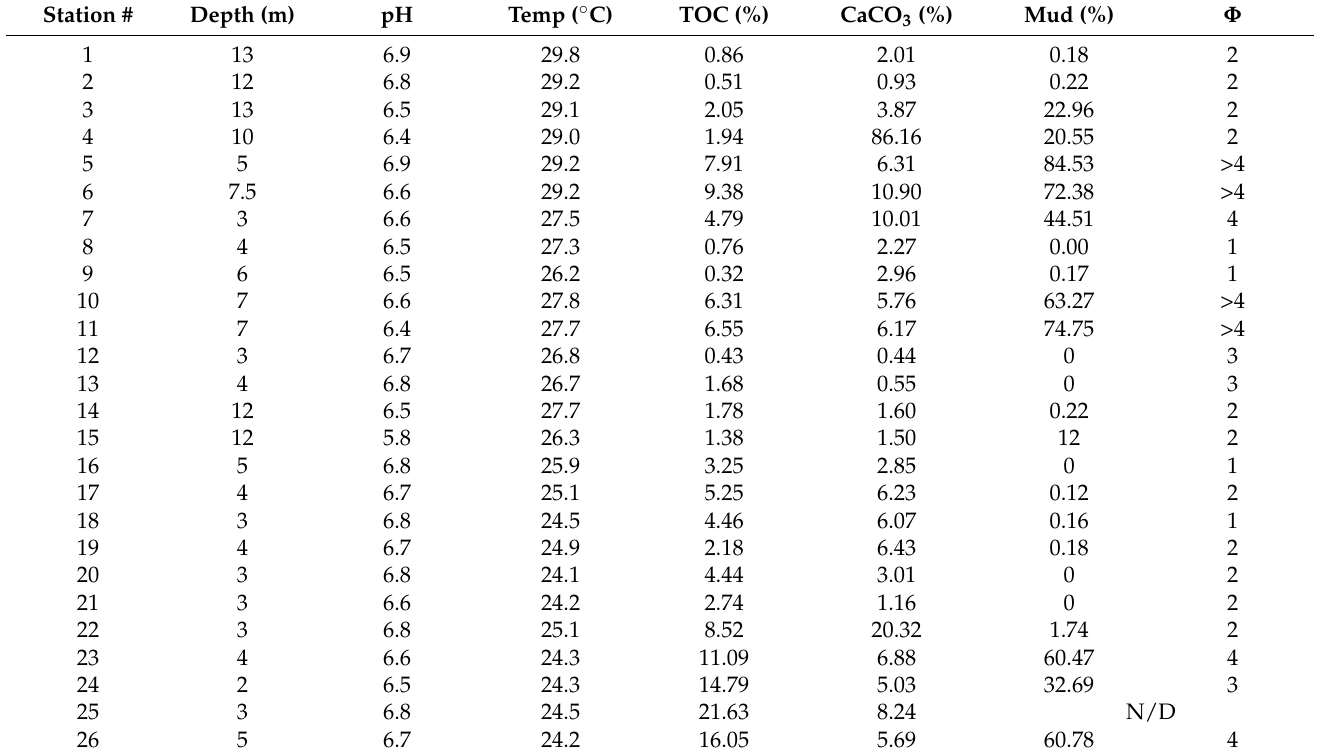
Table 2. Sediment and water characteristics in the Lagos lagoon in May 2019: Depth (m), pH, Temperature ( ◦ C), Total Organic Carbon (TOC), Calcium Carbonate (%CaCO 3 ), mud content (% silt and clay), and Median Grain Size ( Φ ); (N/D = No